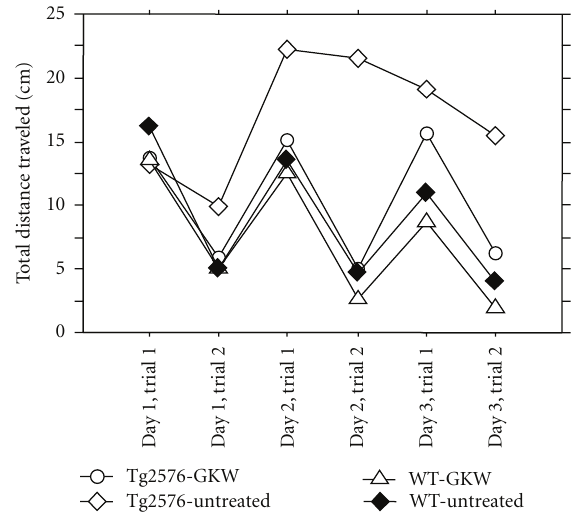
Figure 1: Open-field assay: e ff ect of GKW on total distance trav- elled . Wild-type mice, both treated (triangle) and untreated (filled diamond), are less active on the second trial of each day, presumably due to habituation. Untreated Tg2576 mice (open diamond), in contrast, fail to habituate to the surroundings. GKW-treated Tg25- 76 mice (circles) explore in a manner similar to wild-type mice, with their data overlapping the two wild-type groups. From statistical analysis (ANOVA), P = 0 . 02 for di ff erence between untreated ( n = 7) and GKW-treated ( n = 8) Tg2576 mice; error bars omitted for